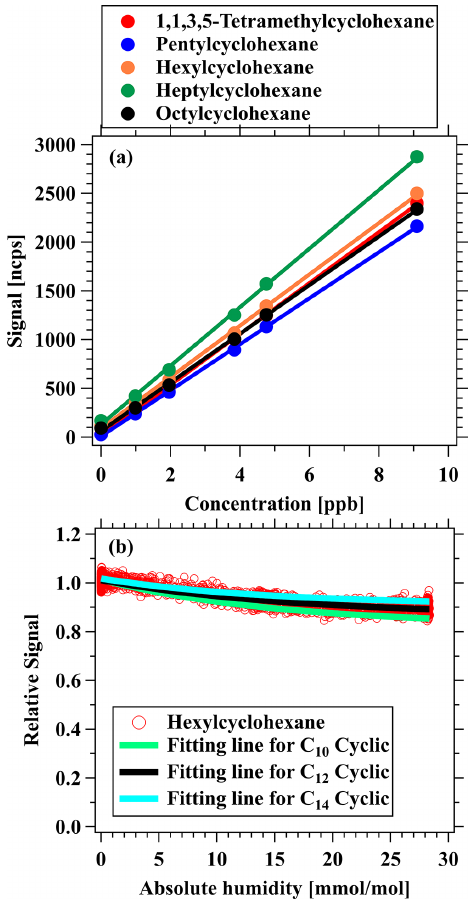
Figure 4. (a) Multipoint calibration curve for 1,1,3,5- tetramethylcyclohexane (red), pentylcyclohexane (blue), hexyl- cyclohexane (orange), heptylcyclohexane (green), and octyl- cyclohexane (black). (b) Humidity dependence of sensitivity for various cycloalkanes, including measurement results for hexylcyclohexane (red markers) and the fitted lines for C 10 cyclic alkane (green), C 12 cyclic alkane (black), and C 14 cyclic alkane (blue), with the corresponding fitted functions of y = 0 . 82 + 0 . 19 × exp( − 0 . 06 x ), y = 0 . 87 + 0 . 14 × exp( − 0 . 06 x ), and y = 0 . 90 + 0 . 11 × exp( − 0 . 07 x ),